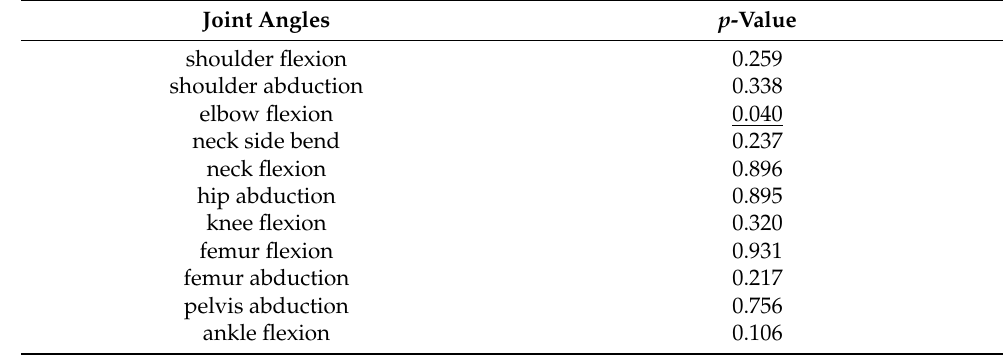
Table 2. Results ( p -value) of one-way repeated measures ANOVA tests for the effect of face blurring on kinematics calculation. Numbers with underscores suggest significant effects ( p -value < 0.05).